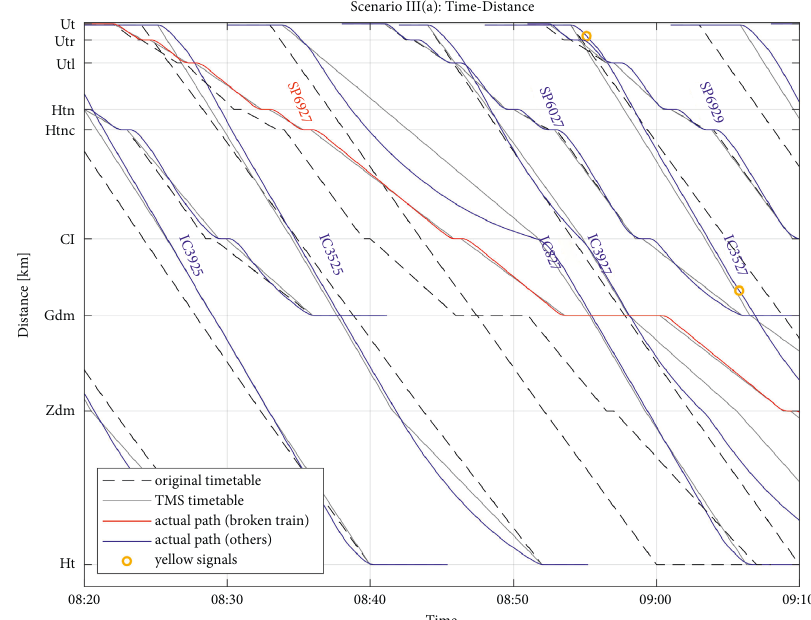
Figure 11: Scenario III(d):